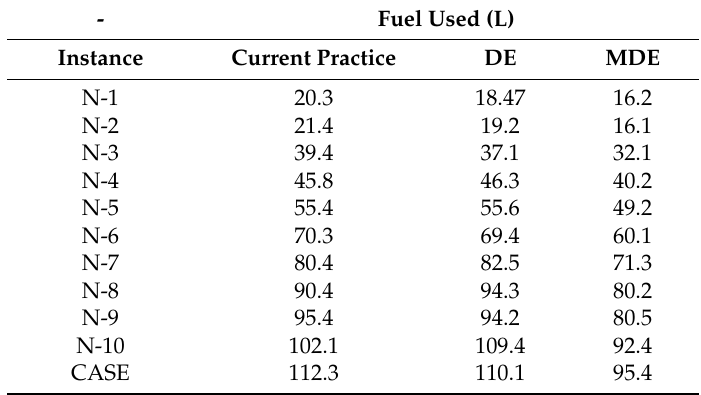
Table 14. The comparison of the current practice and the modified DE (MDE) results.